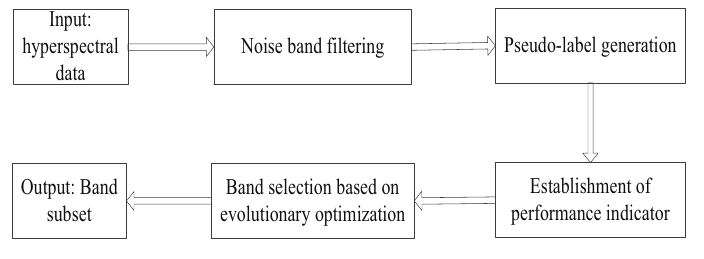
Figure 3. The framework of the proposed